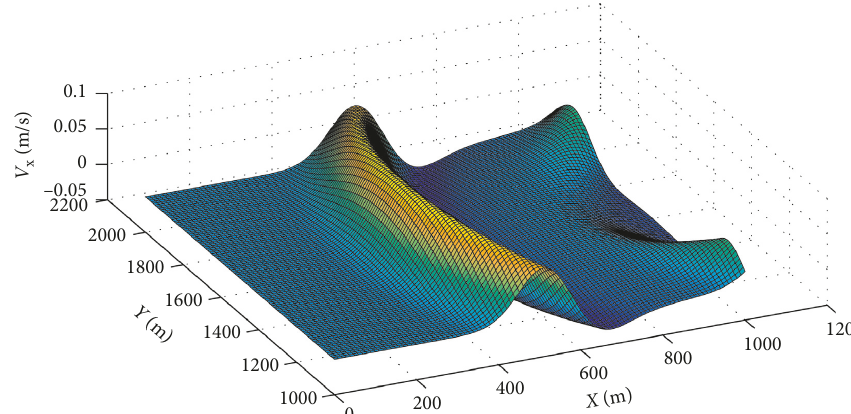
Figure 7: Velocity distribution in the x direction at time �